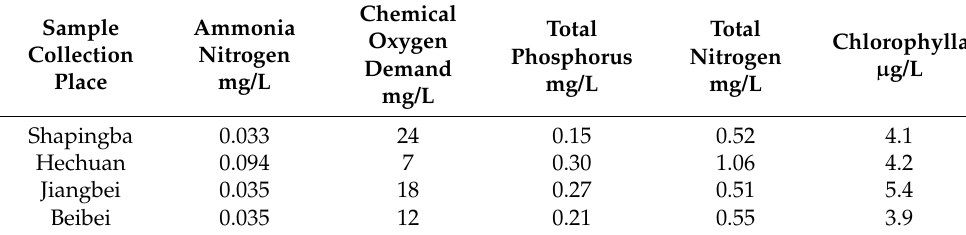
Table 3. Measurement results of water quality